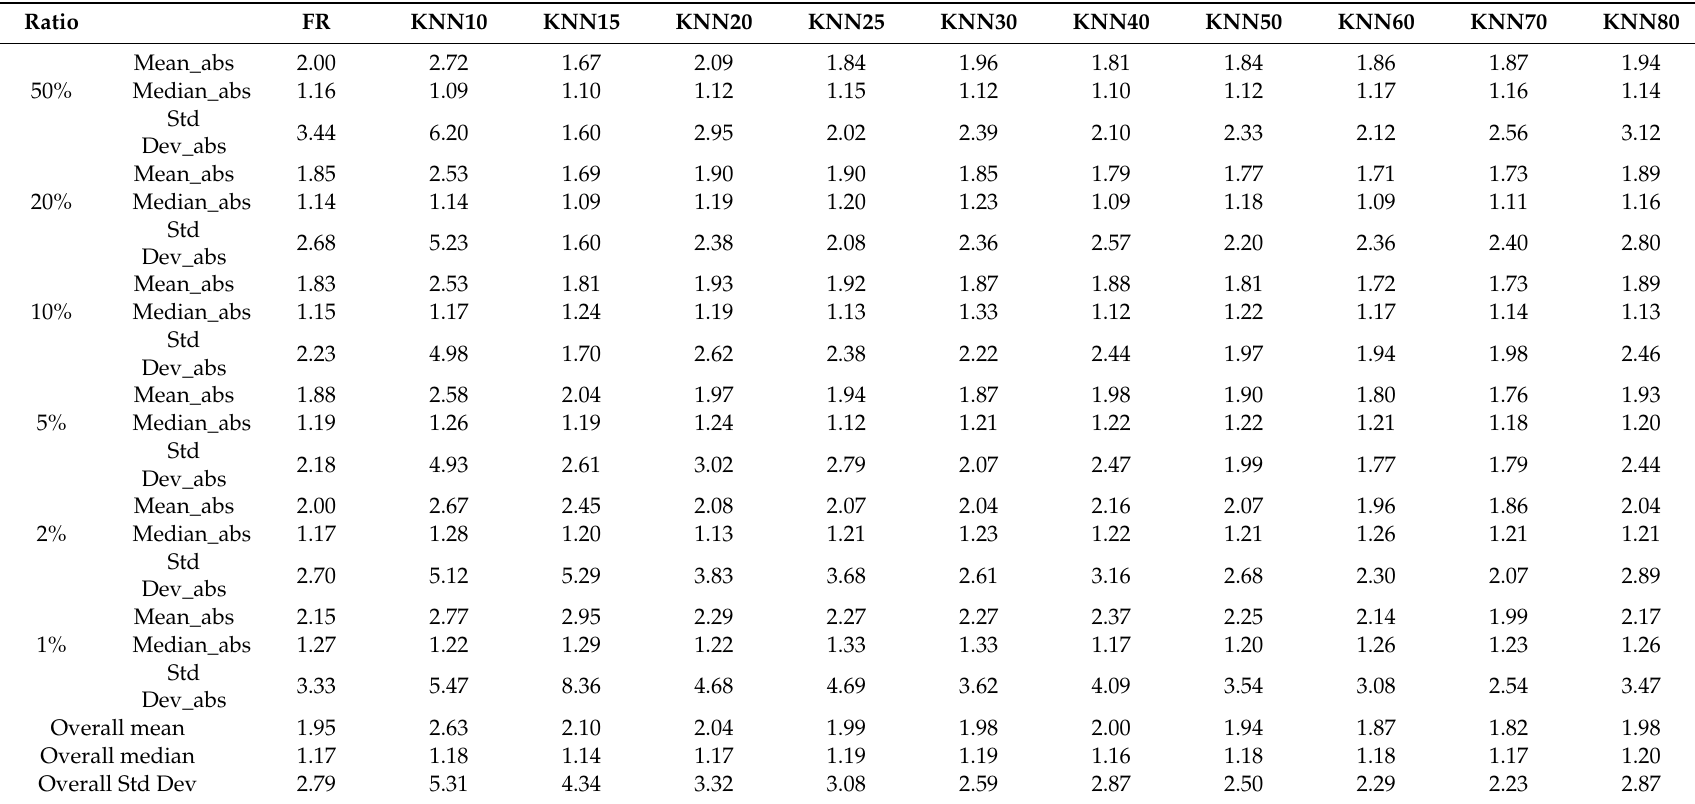
Table 6. Mean, median and standard deviation of Q pred / Q obs ratio for fixed region (FR) and